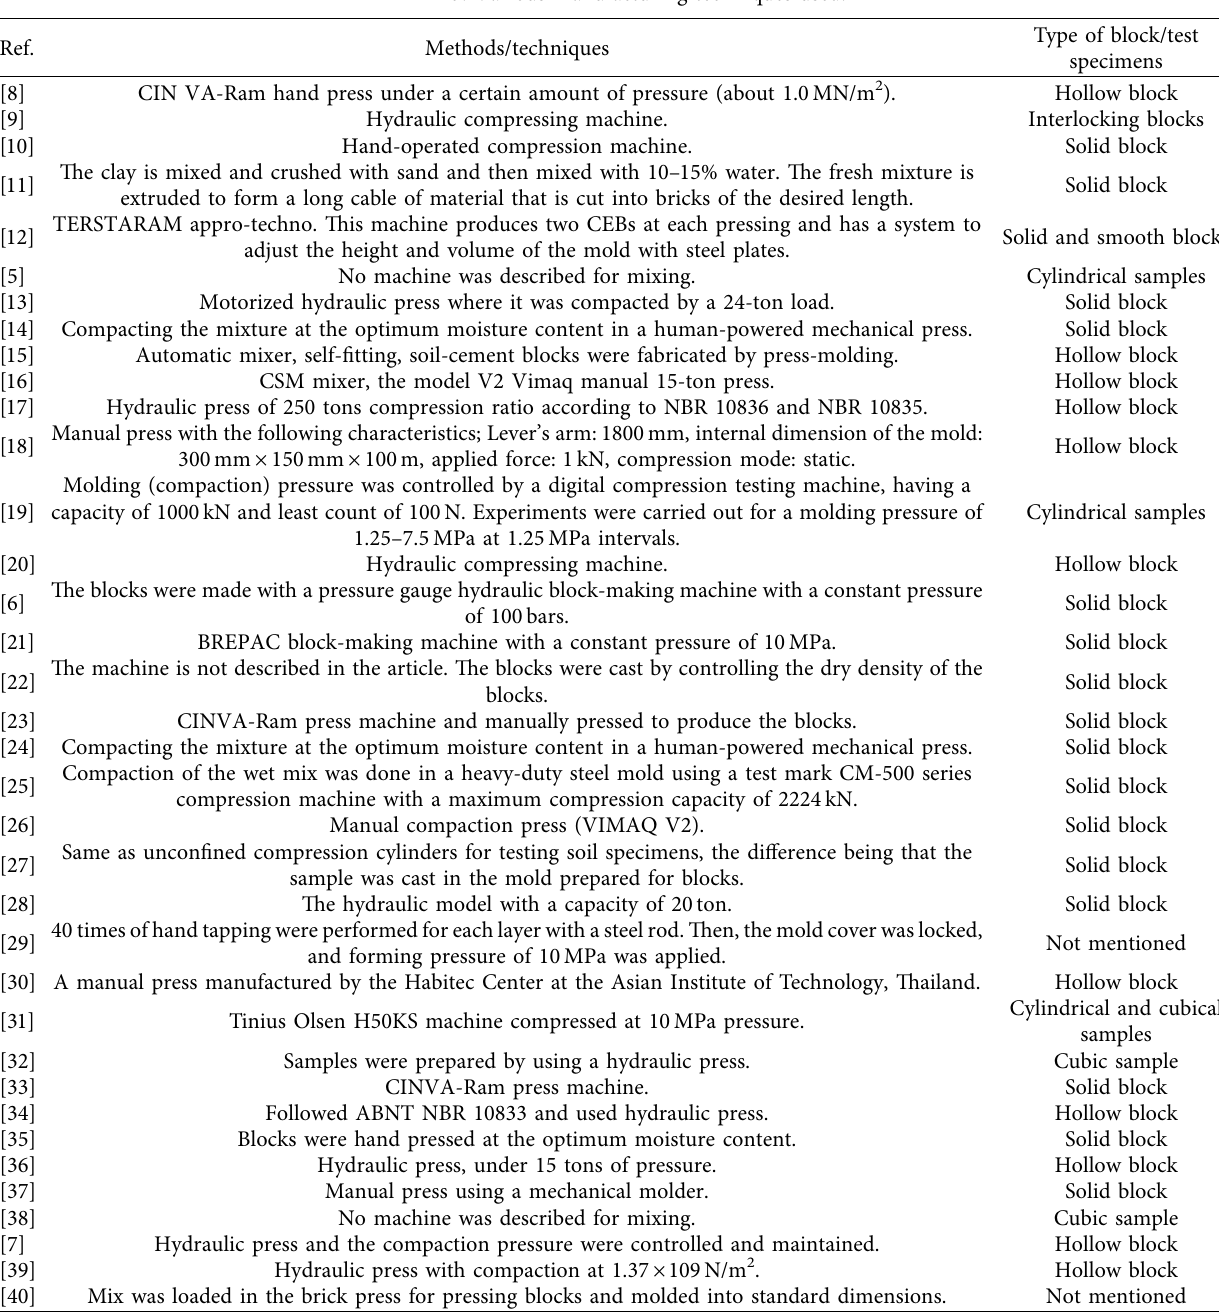
Table 3: Various manufacturing techniques